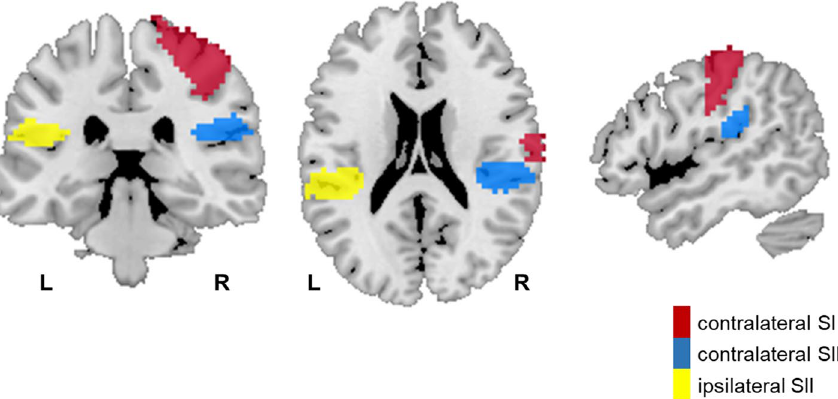
Figure 2. Regions of interest where processing of somatosensory stimuli was investigated: The primary somatosensory cortex contralateral to the stimulus application SI (red) and the secondary somatosensory cortex in both hemispheres SII contralateral (blue) and SII ipsilateral (yellow). Displayed layers intersect at x, y, z = 50, − 30,